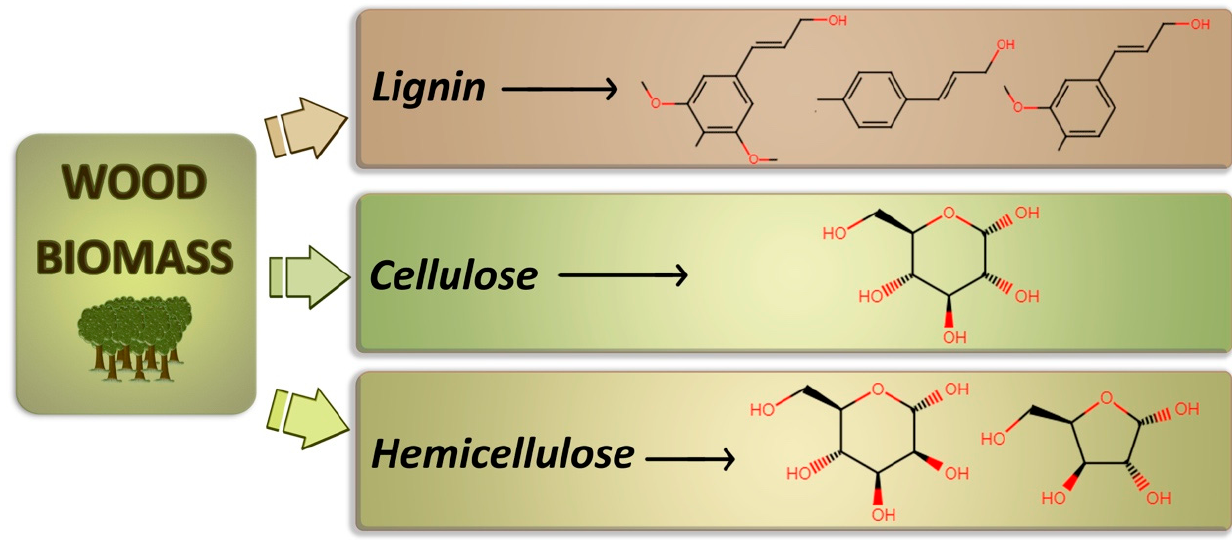
Figure 2. Graphical representation of the main chemical components of vegetal biomasses, i.e., cellulose, hemicellulose and lignin, with schematized molecular